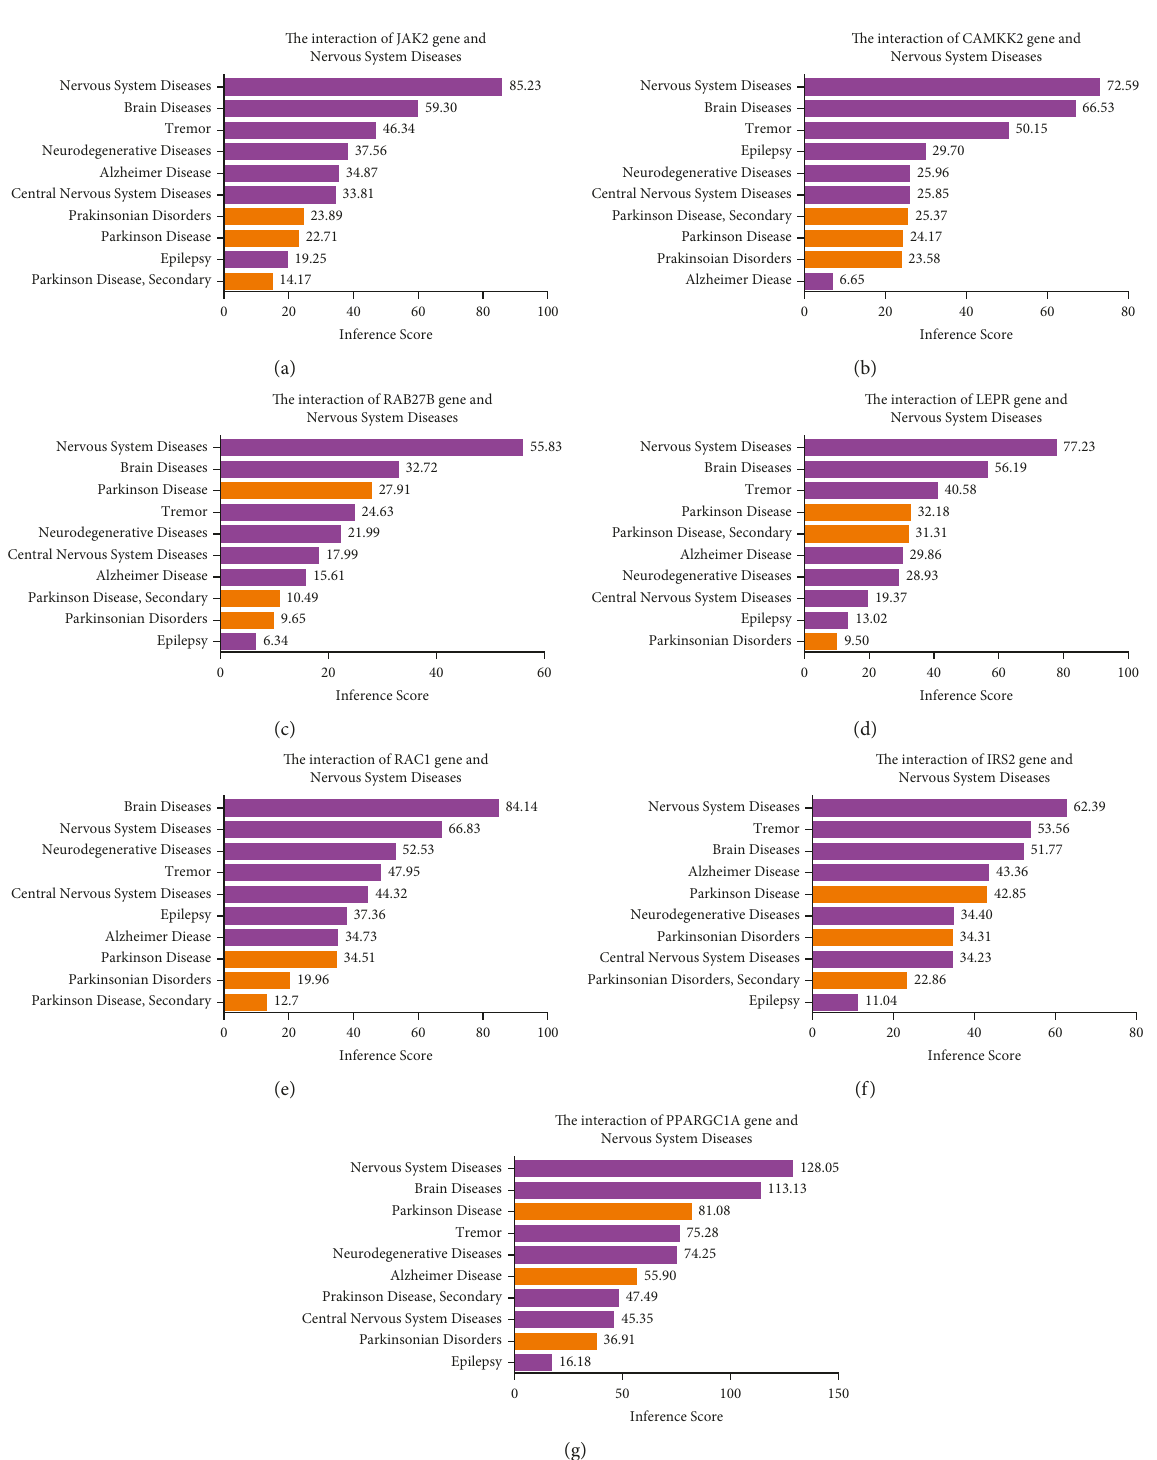
Figure 4: Parkinson’s disease score determined by CTD. The correlation between the genesis of PD and JAK2 (a), CAMKK2 (b), RAB27B (c), LEPR (d), RAC1 (e), IRS2 (f), and PPARGC1A (g) was evaluated by the online tool Comparative Toxicogenomics Database (CTD), scored, and shown as bar